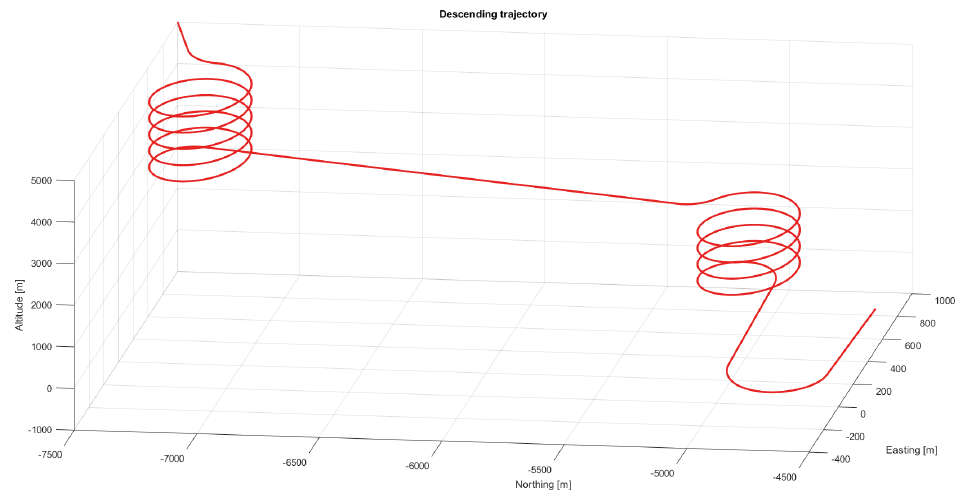
Figure 12. 3D view of the guidance